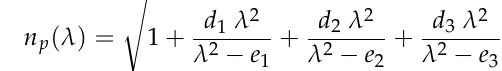
Figure 1. An SPR refractometric sensor consists of prism, silver, Si, and Ti 3 C 2 T x layers. The RI of the BK7 glass prism depends on the light wavelength according to [33]